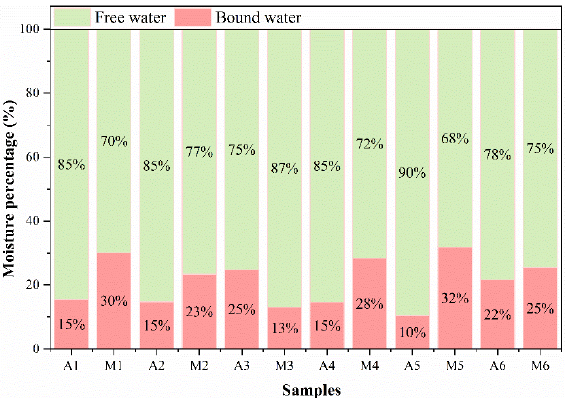
Figure 10. The ratio of bound water and free water to the maximum water content (MWC) in waterlogged archaeological wood (A1–6) and modern wood (M1–6). Note: the values in the figure are the average values of three experimental tests and calculations.